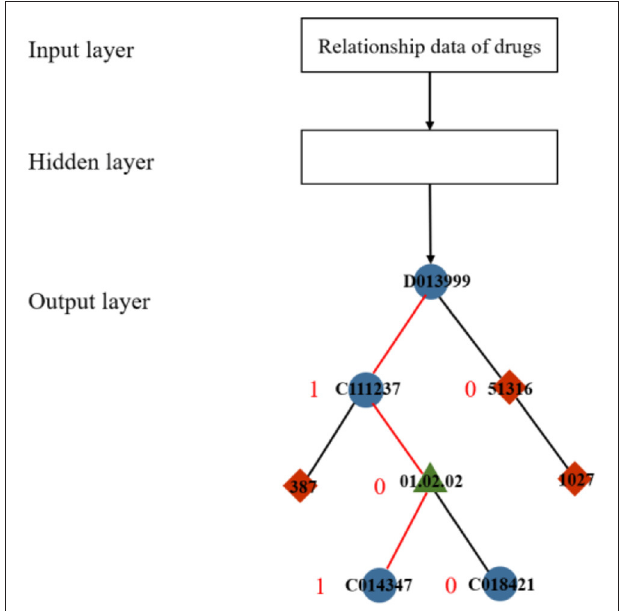
FIGURE 2 | Diagram of hierarchical softmax.